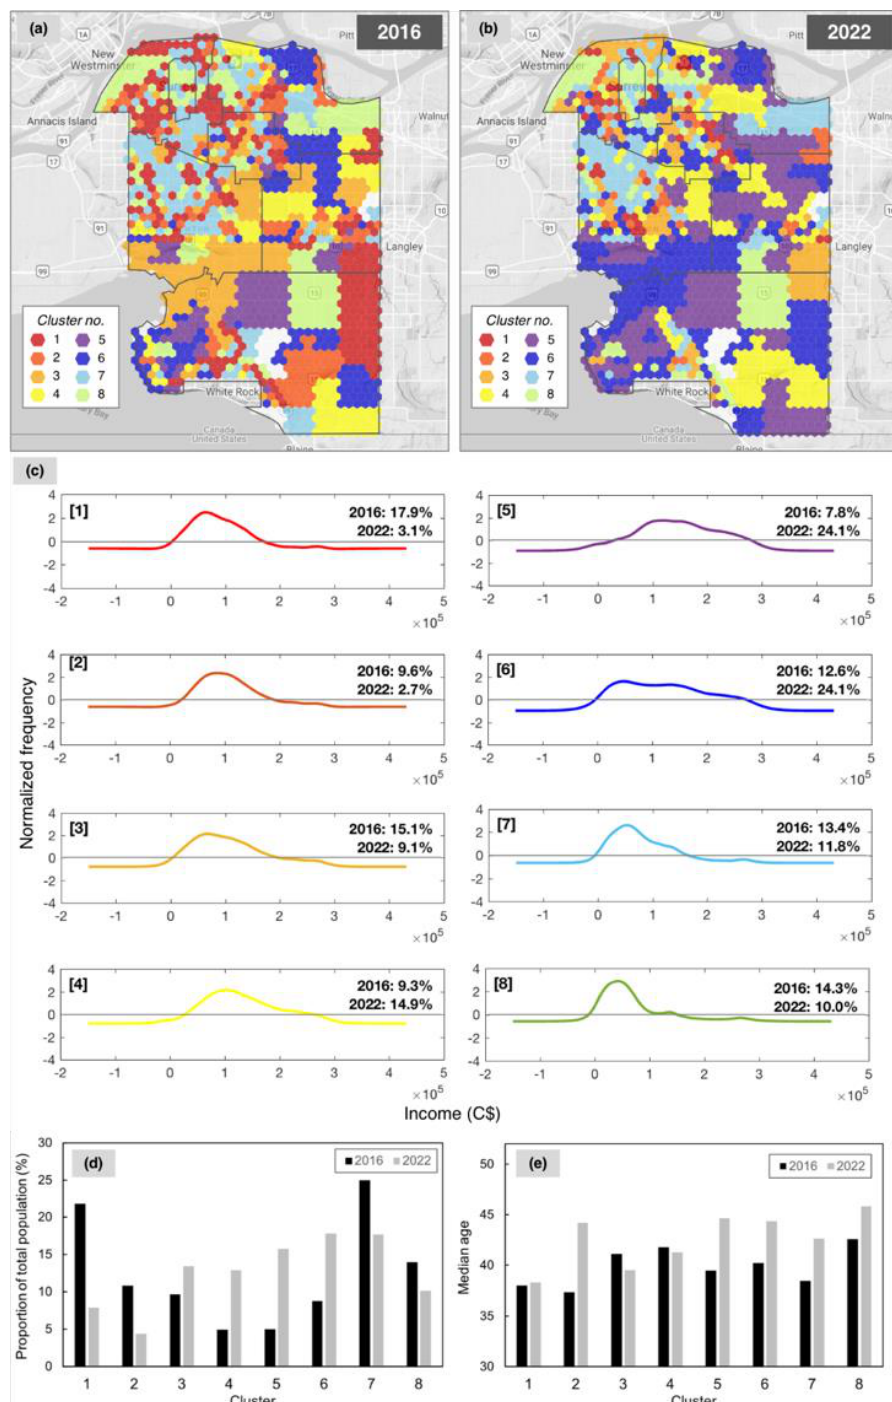
Figure 2. Spatially mapped PCA topology, coloured according to clustering, for ( a ) 2016 and ( b ) 2022. The modes and PCs were calculated using the 2016 dataset and the 2022 data were projected onto the 2016 modes to get the 2022 PCs. White cells show no data; ( c ) Most representative frequency distributions for each PCA cluster, showing in bold the frequency that they occur in the 2016 and 2022 maps. The y -axis on these plots varies about zero because the inputs are demeaned and normalised using their standard deviations; ( d ) Proportion of total city population belonging to each cluster, for 2016 And 2022; ( e ) Median age of population belonging to each cluster, for 2016 and 2022.